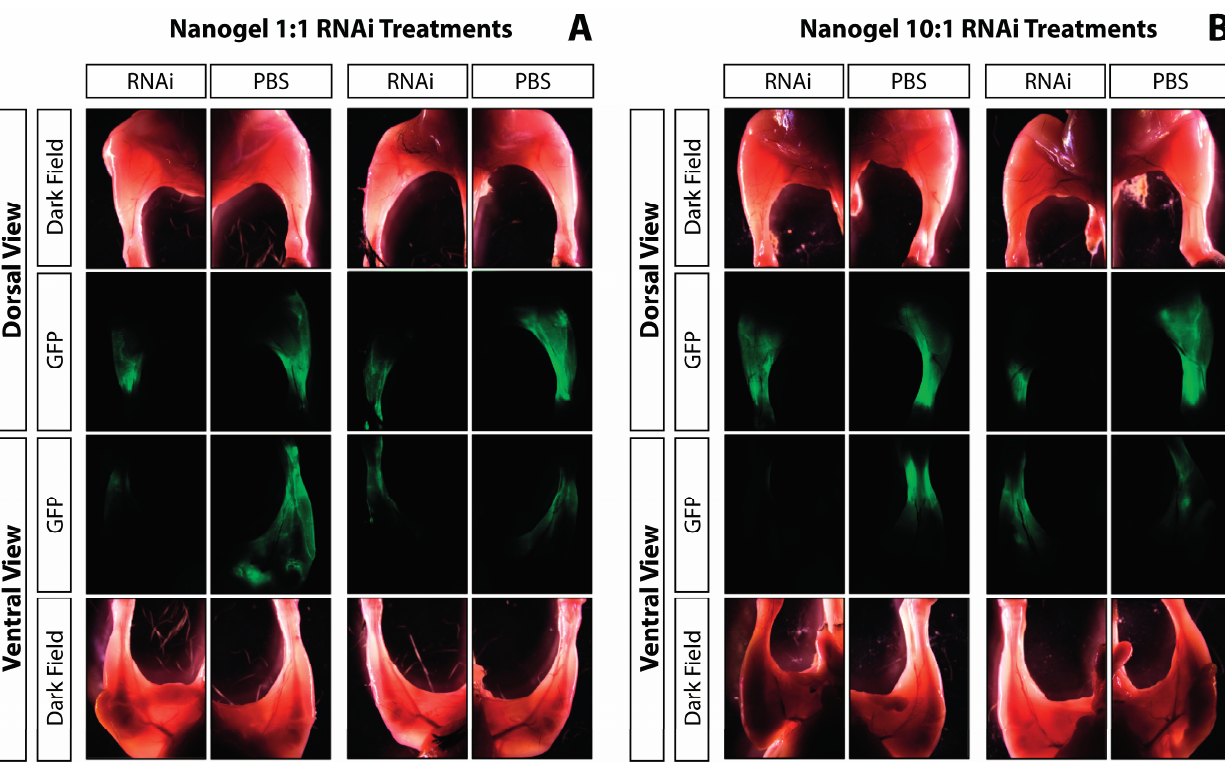
Figure 3. Ratiometric analysis of GFP knockdown by nanogel NSP. Nanogel NSPs were complexed with two μ g of selectively methylated Gfp siRNA (sequence 1) at 1:1 (n = 8) or 10:1 (n = 7) ratios. Treatments were injected to left hind limbs along with 2.2 × 10 8 PFU/site of Adex-GFP. Right hindlegs received the same amount of Adex-GFP mixed with the same volume of PBS. Levels of GFP were observed from dorsal and ventral sides. Photographs were taken from dorsal and ventral sides and levels of fluorescence were quantified using ImageJ grey value analysis function. Left panel: Mean GFP expression in NG1:1 RNAi- treated limbs was 2.80 ± 2.05% and in control (PBS-treated) limbs was 6.07 ± 1.68% ( p = 0.002). Right panel: Mean GFP expression in NG10:1 RNAi-treated limbs was 2.98 ± 1.83% and in control limbs was 4.58 ± 2.27% ( p =